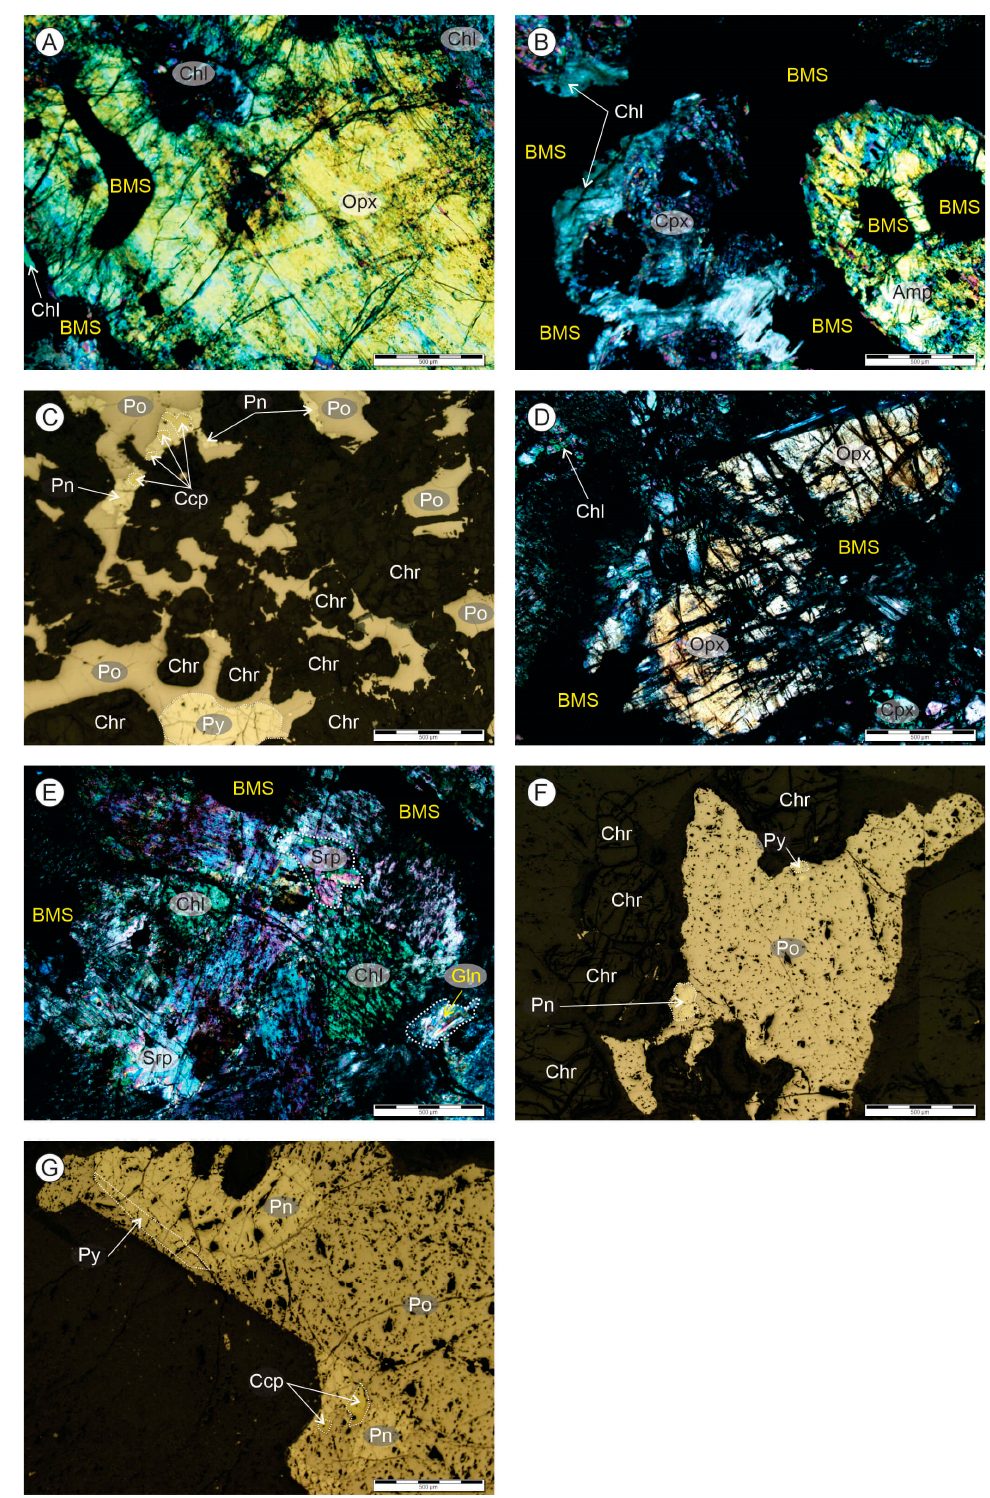
Figure 7. Photomicrographs of disseminated chromite-rich sulfide ore from the Peridotitic Chromitite Mineralized Zone showing various silicates ( A , B , D , E ), sulfides, and chromite ( C , F , G ). The scale bar at the bottom right corner of the images represents 500 µ m. Refer to Figure 2 for explanation of the mineral